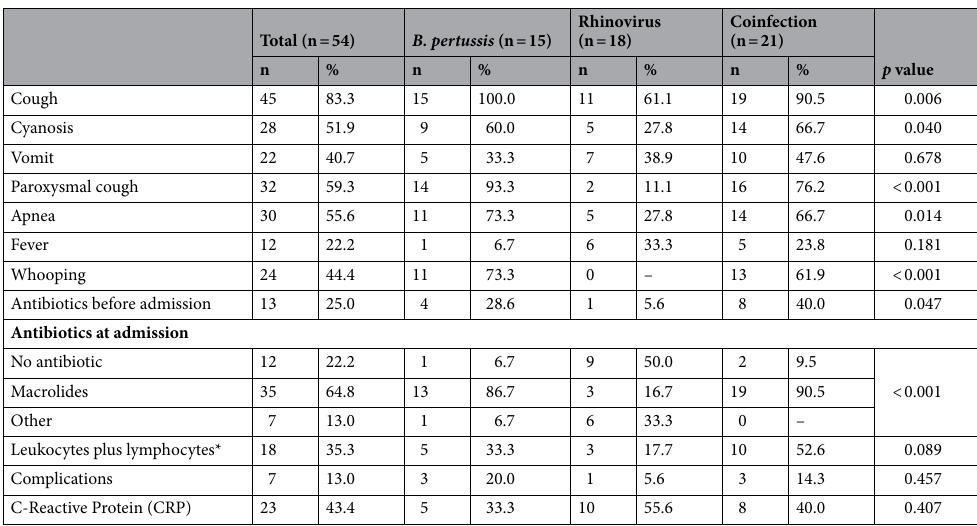
Table 2. Clinical features by group of infection (n = 54). *White cell count > max for age and lymphocytes >